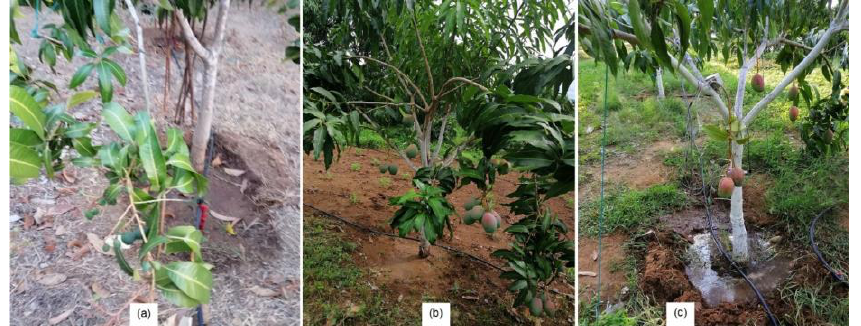
Figure 4. Water within the furrow of a mango HD tree during ( a ) dry season, ( b ) a rain event, and ( c ) fruit growth.